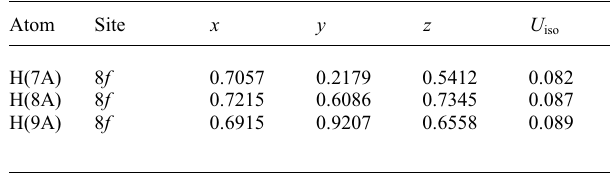
Table 3. Atomic coordinates and displacement parameters (in Å 2 )